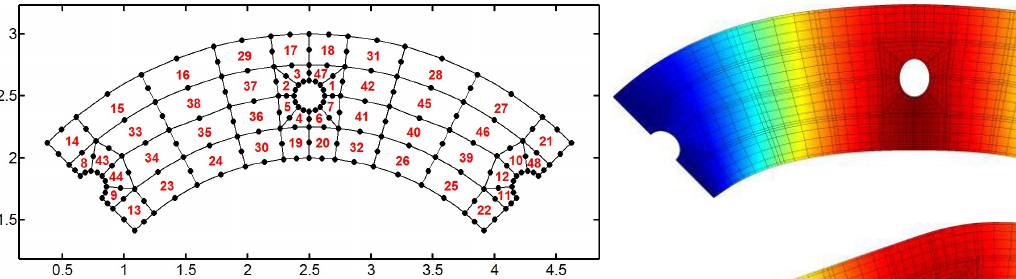
Figure 19: SFEM mesh of a laminated composite circular arch with circular holes.